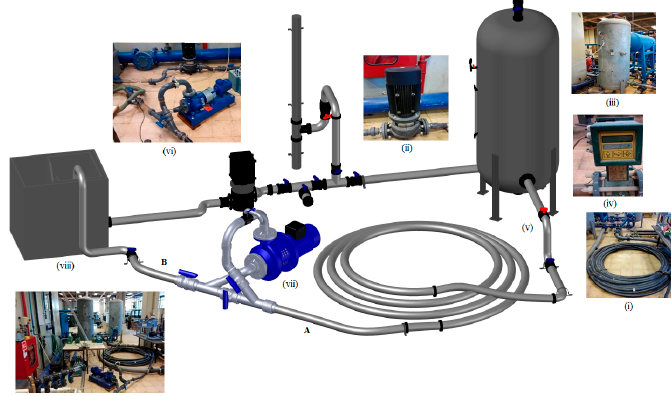
Figure 1. Experimental facility at Instituto Superior Técnico (IST) lab.